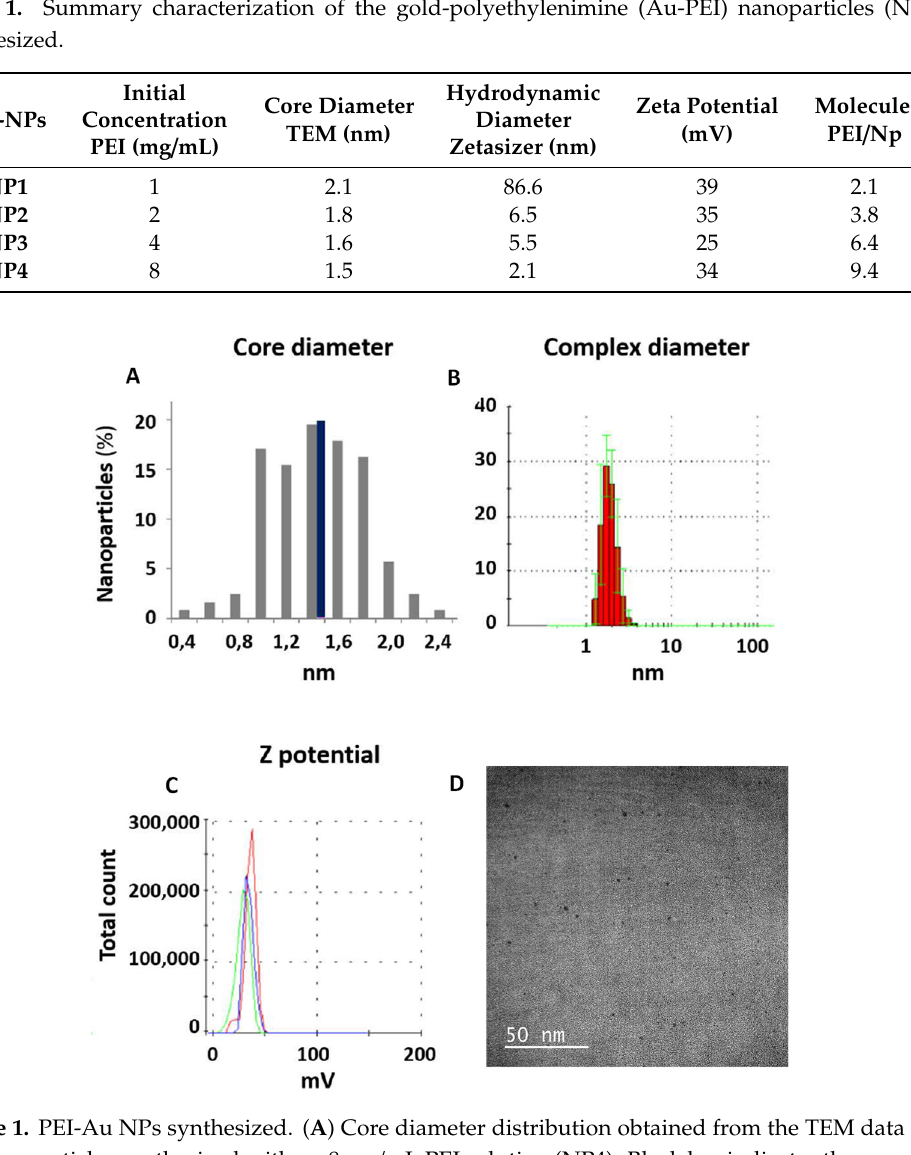
Figure 1. PEI-Au NPs synthesized. ( A ) Core diameter distribution obtained from the TEM data for the nanoparticles synthesized with an 8 mg / mL PEI solution (NP4). Black bar indicates the average size ≈ 1.5 nm. ( B ) Analysis of NP4 hydrodynamic diameter ≈ 2.10 nm. Measurements made by the particle size analyzer to the NPs synthesized with a solution of 8 mg / mL of PEI (NP4). ( C ) NP4 zeta potential ≈ 34 mV. ( D ) Representative TEM image of NP4.